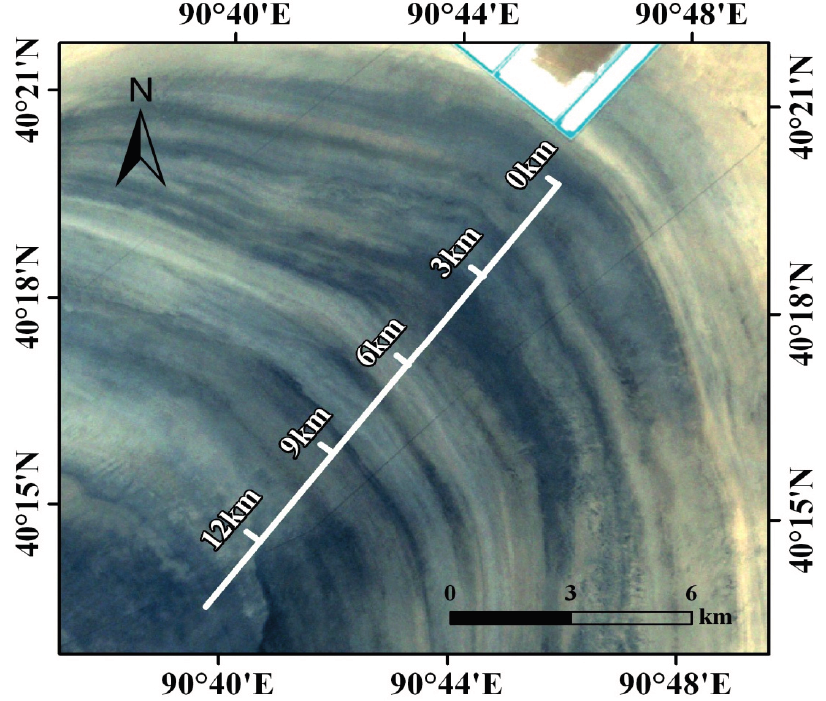
Figure 6. Transversal profile to the rings of the “ear” in Lop Nur. (the background Landsat TM 5 image acquired on 23 August 2007; band 3 = red, band 2 = green, band 1 = blue). The transversal profile location was shown in Figure 1.